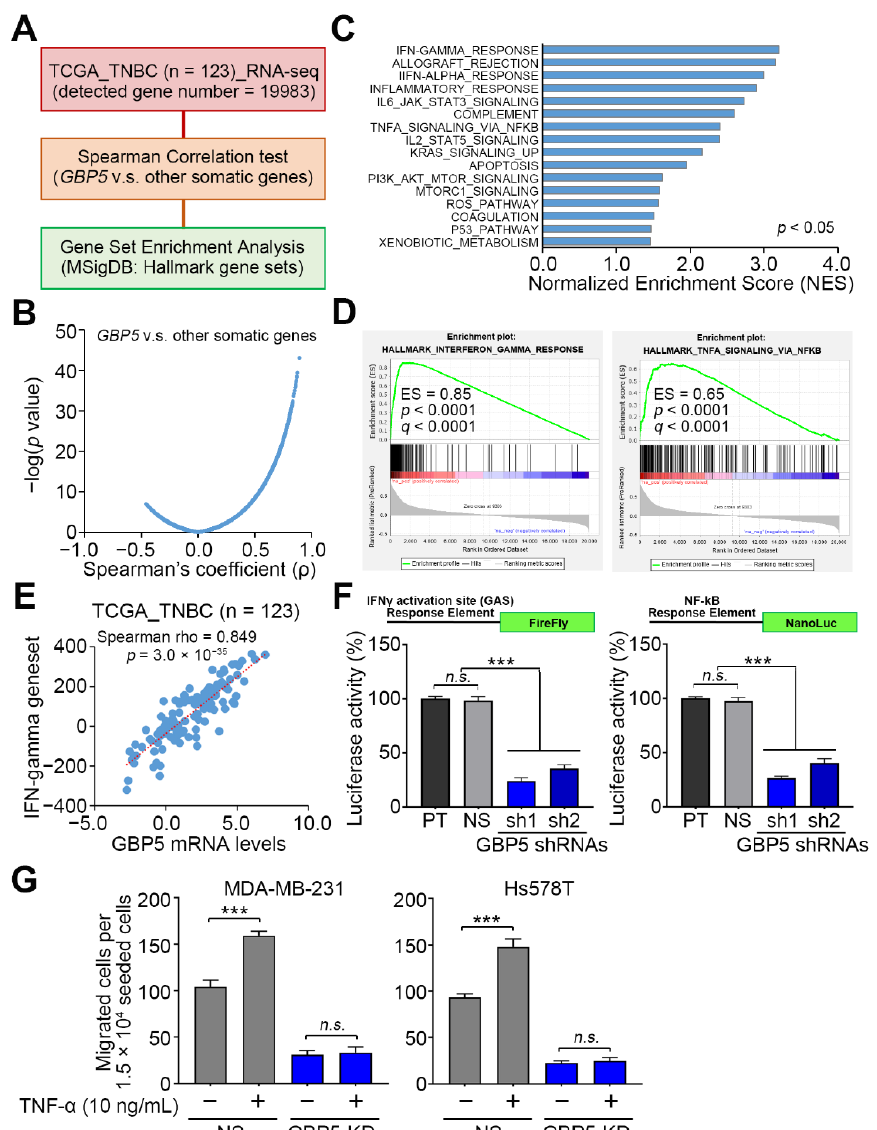
Figure 4. GBP5 knockdown downregulates the activity of IFN- γ and NF- κ B in TNBC cells. ( A ) Flow chart of generating the GBP5 signature from TNBC samples from the TCGA database for GSEA simulation. ( B ) A volcano plot for the Spearman’s coefficient ( p ) values and—log ( p values) derived from the Spearman correlation test against the coexpression of GBP5 with other somatic genes detected by RNA-sequencing tool in 123 TNBC samples deposited in the TCGA database. ( C ) A histogram for normalized enrichment scores derived from GSEA simulation using hallmark gene sets deposited in the molecular signature database (MSigDB) against the GBP5 signature. ( D ) The enrichment score (ES) derived from the correlation of the GBP5 signature with the IFN- γ -responsive (left) and TNF- α /NF- κ B signaling axis-related (right) gene signatures was plotted as the green curve. The parameters of the enrichment score, nominal p value and false discovery rate q value are shown as insets. ( E ) Scatchard plot for the expression of GBP5- and IFN- γ -responsive gene sets in TNBC samples from the TCGA database. The Spearman correlation test was used to evaluate the statistical significance. The dashed/red line represents the regression line. ( F ) Constructs of the firefly luciferase gene adjacent to the promoter harboring the IFN- γ activation site (GAS) response element (upper left) and NanoLuc luciferase gene adjacent to the promoter harboring the NF- κ B response element (upper right), and histograms of the firefly (lower left) and NanoLuc (lower right) luciferase activities detected in the indicated MDA-MB-231 cell variants. ( G ) The histograms for the migrated cells in the non-silencing control and GBP5-knockdown (GBP5-KD) MDA-MB-231 (left) and Hs578T (right) cells without or with TNF- α pretreatment at 10 ng/mL for 24 h. In ( F , G ), the error bars denote the data from three independent experiments presented as the mean ± SEM. A nonparametric Friedman test was used to analyze the statistical significance. The symbols “***” and “n.s.” represent p < 0.001 and not significant,